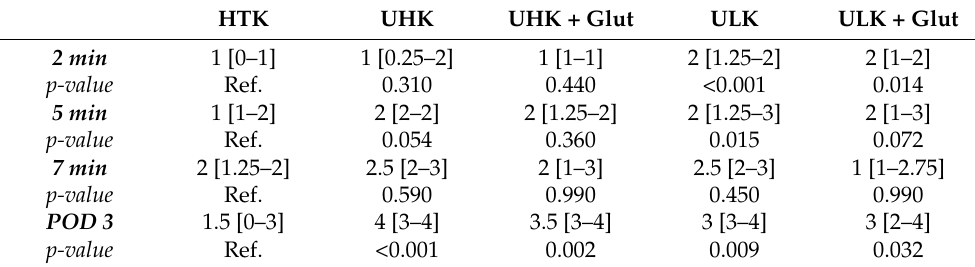
Table 5. Functional cardiac scores (median [IQR]) and intergroup comparison between HTK (refer- ence) and Unisol-based perfusates using the Kruskal–Wallis test with Dunn’s multiple comparison correction. IQR, interquartile